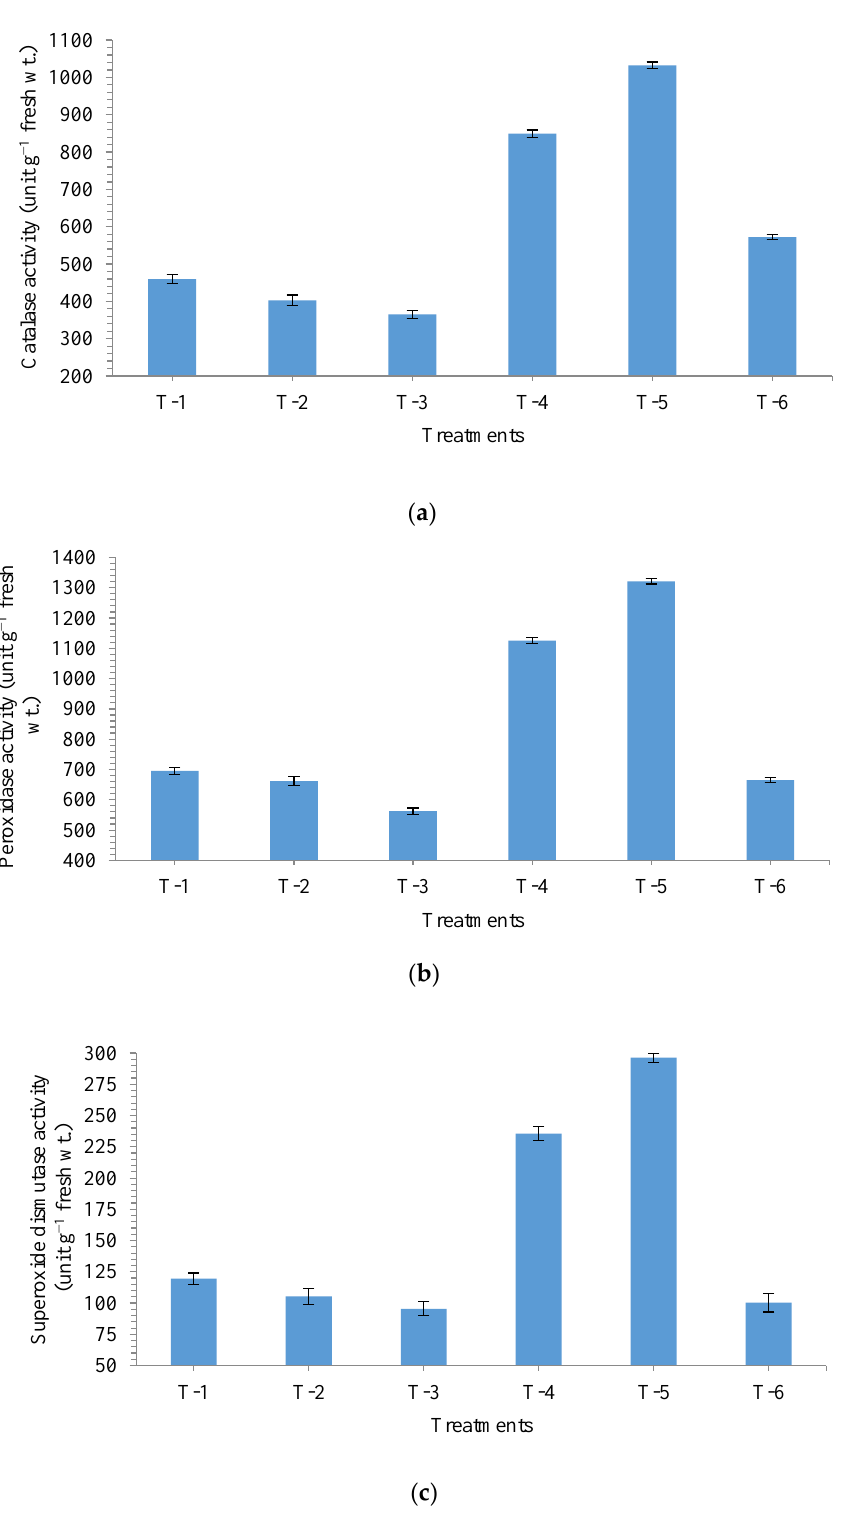
Figure 6. Effects of seed bio-primingon activity of antioxidant enzymes ( a ) catalase activity, ( b ) peroxidase activity, and ( c ) superoxide dismutase activity in maize at 30 days after sowing. Treatments were: T 1 -Saline sodic soil (Negative control), T 2 -Non-saline sodic soil + Salt (NaCl 150 mM), T 3 -Non-saline sodic soil (Positive control), T 4 -Saline sodic soil + Pseudomonas geniculata MF-84, T 5 -Non-saline sodic soil + Salt (NaCl 150 mM) + Pseudomonas geniculata MF-84 and T 6 -Non-saline sodic soil + Pseudomonas geniculata MF-84. Data are mean ± SEM (n = 5).